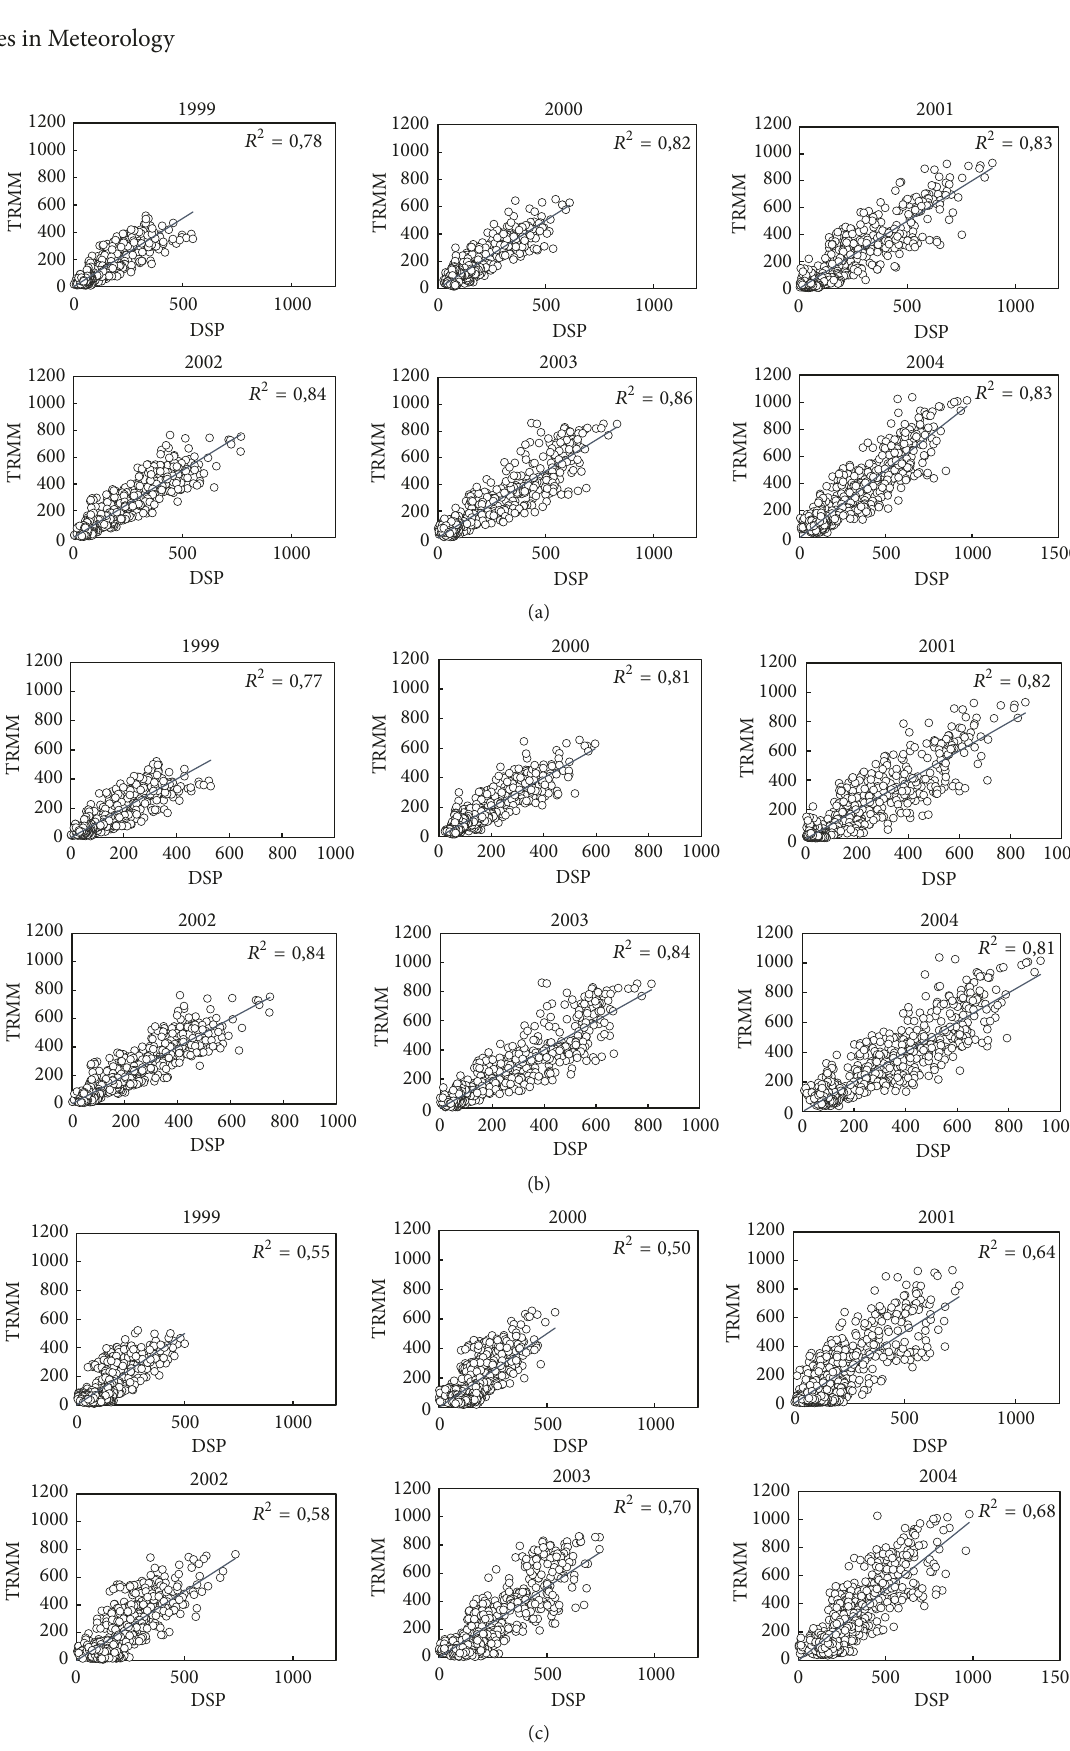
Figure 8: Scatterplot matrix of TRMM 3B43 versus downscaled and calibrated precipitation (DSP) according to Groups 2 (a), 3 (b), and 4